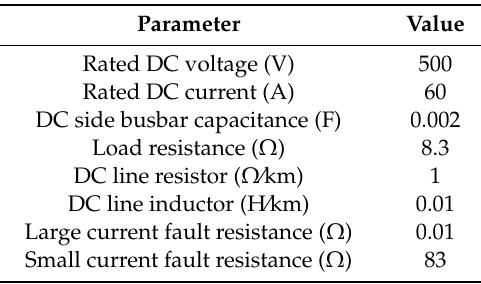
Figure 8. Equivalent circuit of LVDC distribution network connected by DC FCL.